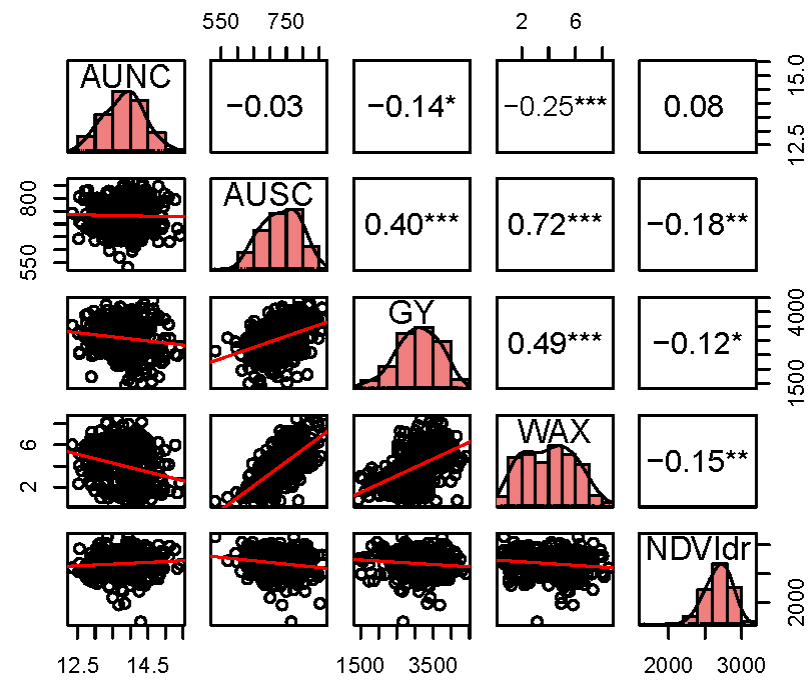
Figure 1. Pearson correlation values for pairs of phenotypic traits evaluated using the trait means calculated from all four field experiments conducted in 2016 and 2017. For each pair of traits indicated, the panel at the lower left intersection is the raw data, while the panel at the upper left intersection is the Pearson correlation value. The panel with the trait label indicates the distribution of the data. Significance: * p ≤ 0.05, ** p ≤ 0.001, *** p ≤ 0.0001. Abbreviations: AUNC = Area under NDVI curve, AUSC = Area under SPAD curve, GY = Grain yield, NDVIdr = NDVI derived from UAV/drone data.